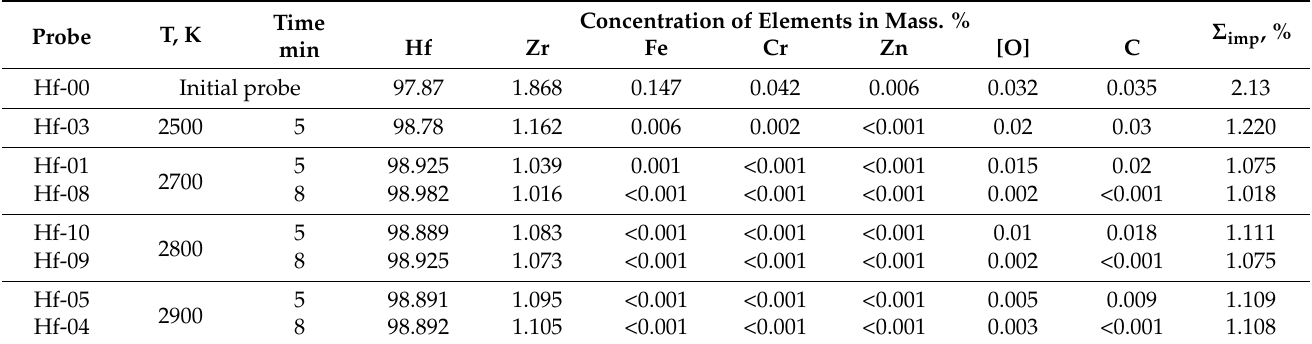
Table 2. Process parameters and chemical composition of ingots before and after single refining of technogenic hafnium during EBM.